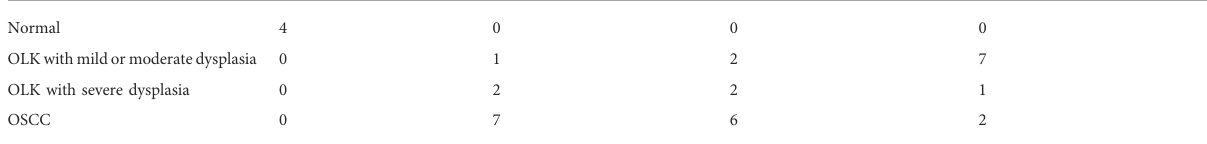
TABLE 1 Pathological diagnosis of mouse tongue tissue in each